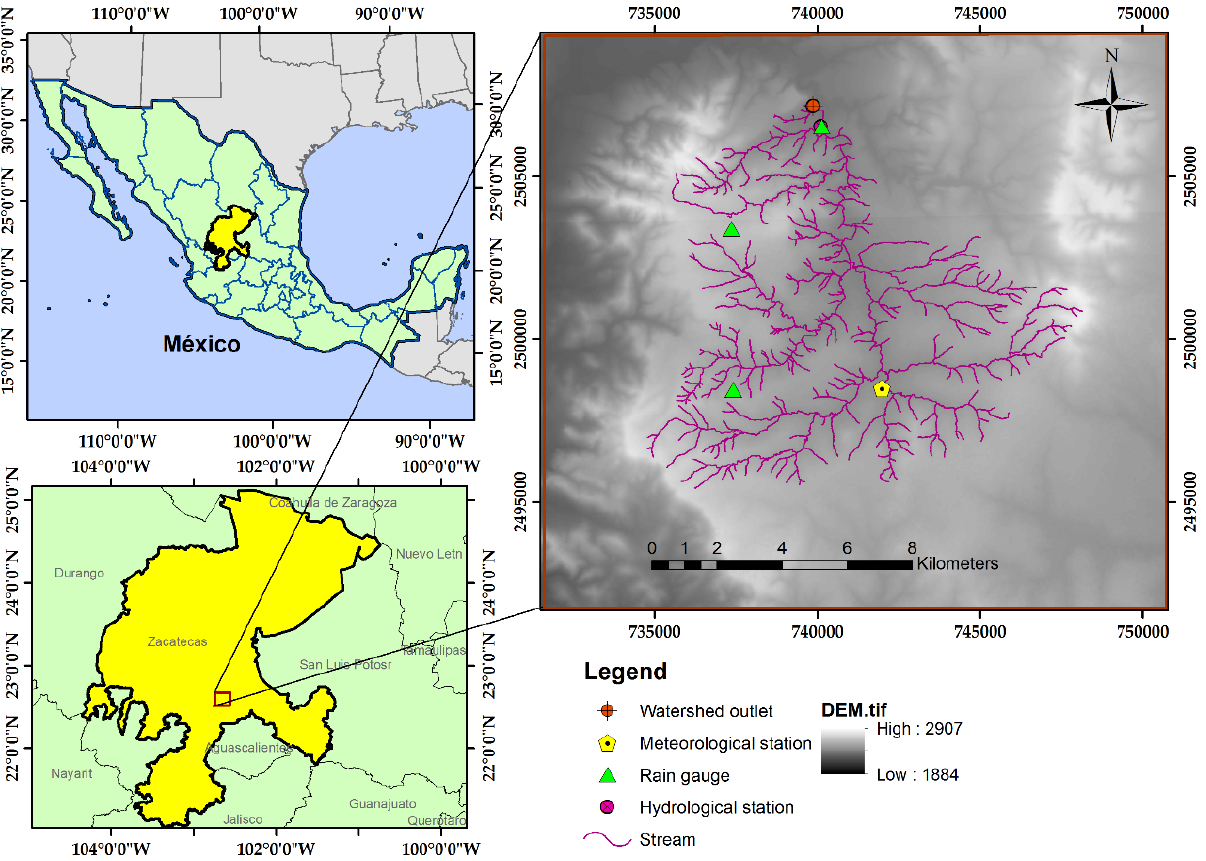
Figure 1. Location of the study site.